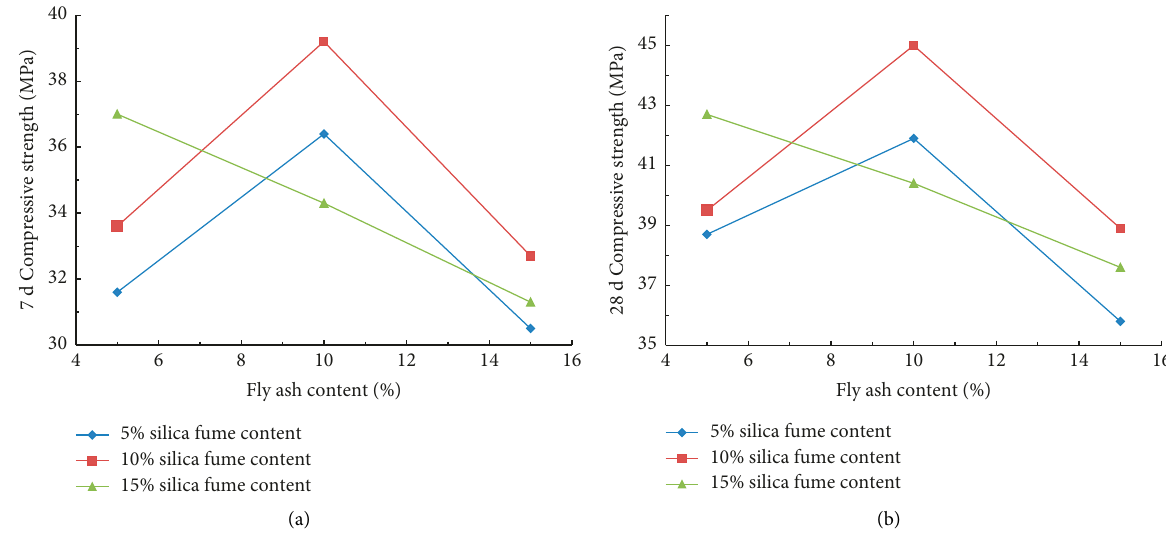
Figure 9: Influence of fly ash content on compressive strength of MPPF coral concrete. (a) Influence of fly ash content on compressive strength of concrete in 7 d. (b) Influence of fly ash content on 28 d compressive strength of concrete.